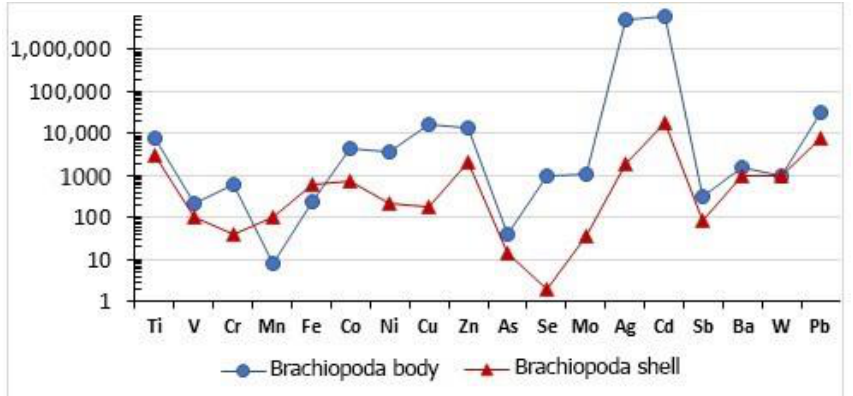
Figure 13. Distribution pattern of the trace element BCF in gills, the rest of soft body, and shell of